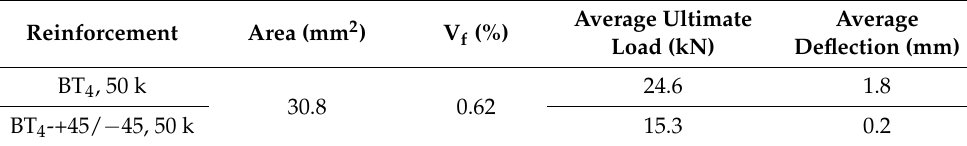
Table 4. Ultimate loads and deflections of ± 45 ◦ TRC beams.